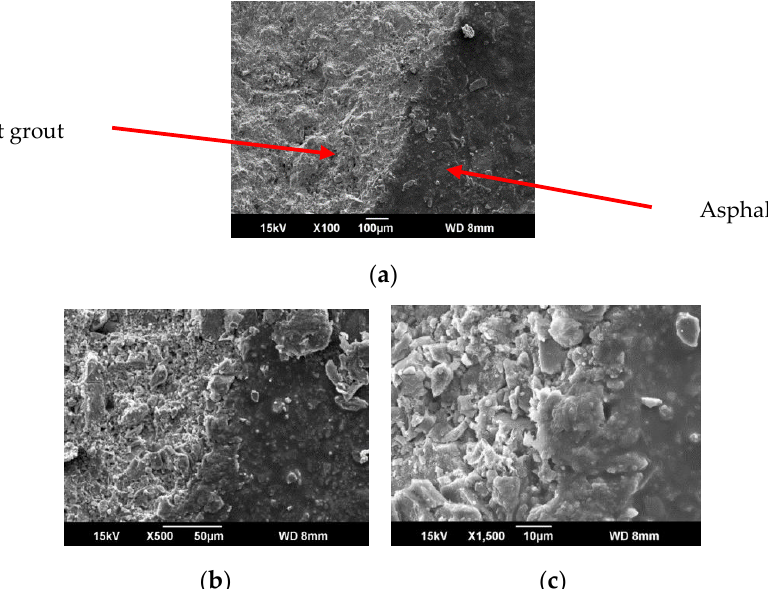
Figure 5. Microstructure of cement-asphalt interface modified by cationic emulsified asphalt with different sizes: ( a )100 μ m;( b ) 50 μ m; ( c ) 10 μ m.